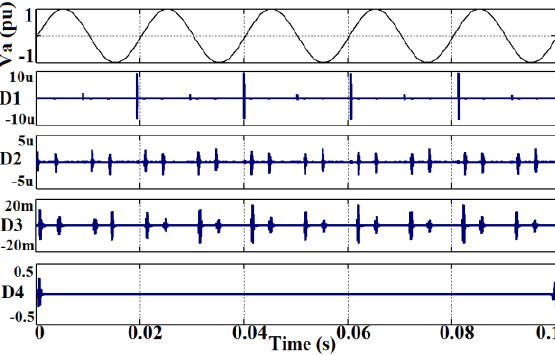
Figure 14. DWT details for HIF